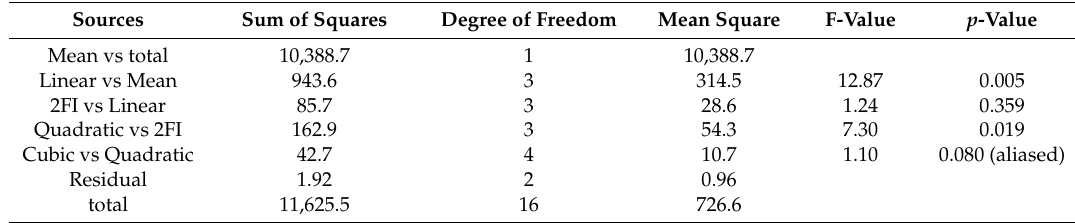
Table 7. Sequential model sum of squares for haze.